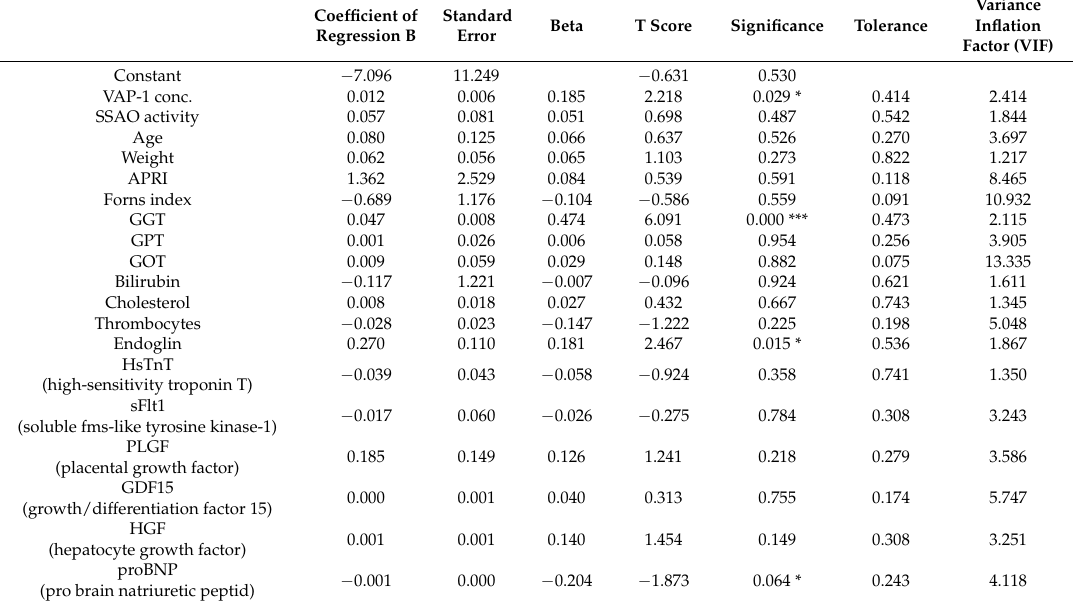
Table 3. Linear regression analysis for independent predictors of liver stiffness. All variables correlating with liver stiffness are included in the model. We determined the regression coefficients with standard error, the beta coefficient and the statistics for co-linearity (tolerance and variance inflation factor (VIF)). Statistical outcome: R = 0.855, R 2 = 0.730, significance < 0.001 ***. Gamma-glutamytransferase (GGT) was the strongest significant influencing variable for liver stiffness followed by VAP-1. Significance is given as * p < 0.05, and *** p <